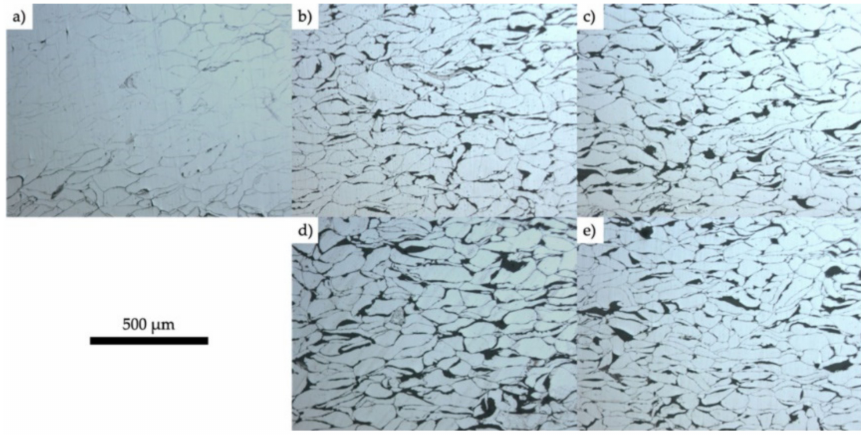
Figure 5. Optical micrographs of ( a ) Mg-0HAP, ( b ) Mg-8HAP, ( c ) Mg-10HAP, and ( d ) Mg-12HAP, and ( e ) Mg-10HAP106 after sintering using SPS system [51].